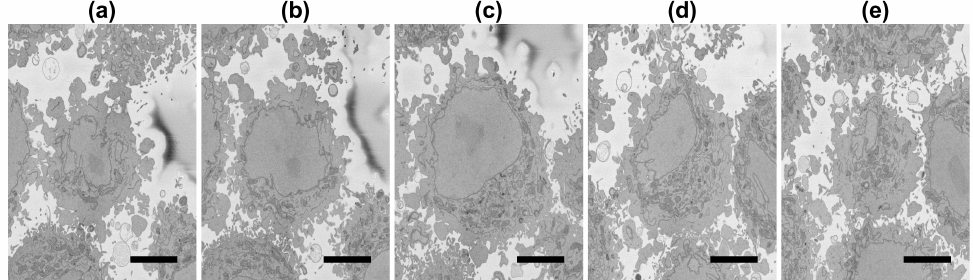
Figure 3. ( a – e ): Five representative slices of the 2000 × 2000 × 300 region of interest (ROI) with the central slice ( c ) corresponding to the blue box in Figure 2. It should be noticed how the nucleus decreases in size towards top ( d , e ) and bottom ( a , b ) of the cell. Also, the nuclei of the cells that surround the central cell are particularly visible towards the bottom of the cell ( a ) at the left side and top of the cell ( e ) at the right and bottom of the image. Scale bar at the bottom right indicates 5 µ